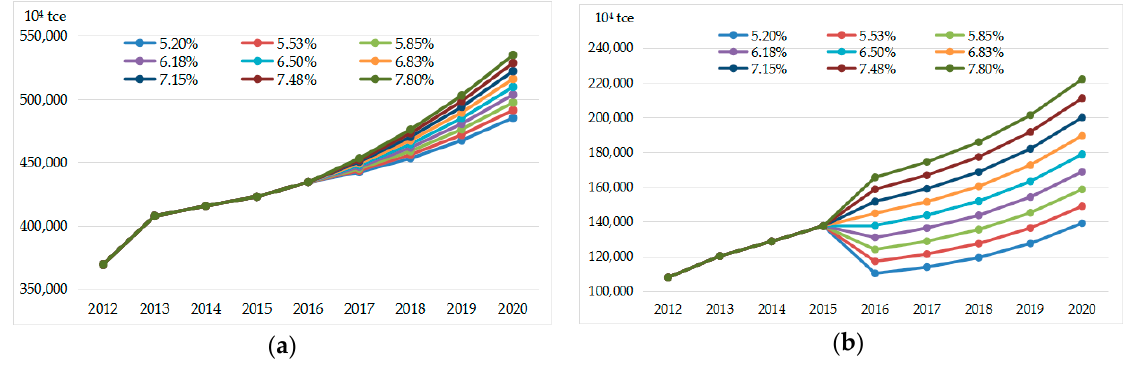
Figure 3. Energy consumption under different GDP growth rates for ( a ) TPEC and ( b ) EECS.